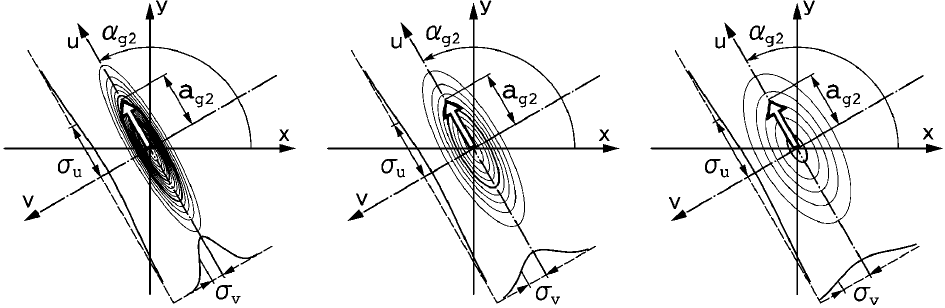
¼ 7 and (cid:9) ¼ g 2 g 2